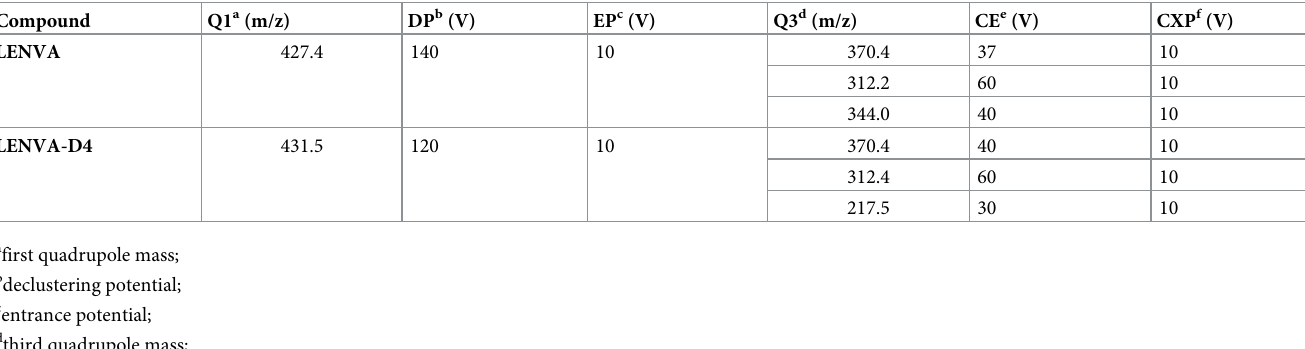
eluent B (methanol/isopropanol (90:10, v/v) with 0.10% of formic acid (v/v), eluent A: ultra- pure water plus 0.10% formic acid (v/v)) was increased from the starting condition of 5% to 98% in 1.50 min, and then kept constant for 1.15 min to ensure an efficient-column washing; the initial condition was then restored in 0.10 min, and the column was re-equilibrated for 1.25 min. The total run time was 4.00 min. Fig 2 displays typical SRM chromatograms of plasma samples: an extracted blank plasma sample (Fig 2A), a zero blank sample containing IS only (Fig 2B), an extracted plasma sample at the LLOQ (Fig 2C), and a sample from a patient collected 4.5 hours after drug intake (dose 12 mg) with a measured LENVA concentration of 99.6 ng/mL (Fig 2D). As shown from the figure, the analyte was rapidly eluted, with a retention time of 1.40 min.